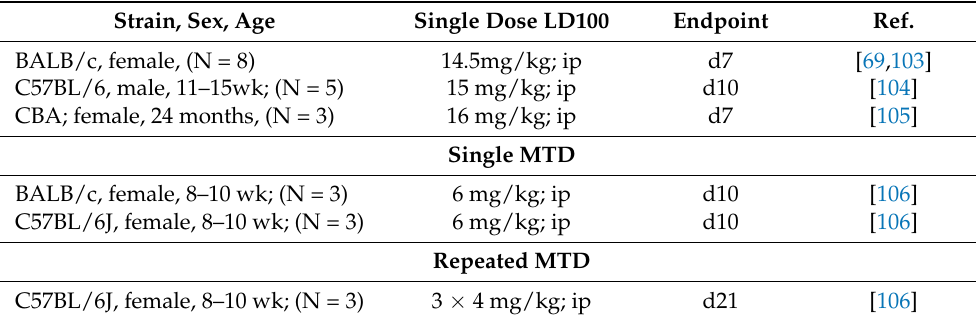
Table 3. Cisplatin acute toxicity and single or repeated maximum tolerated dose given intraperi- tonealy varies among mouse